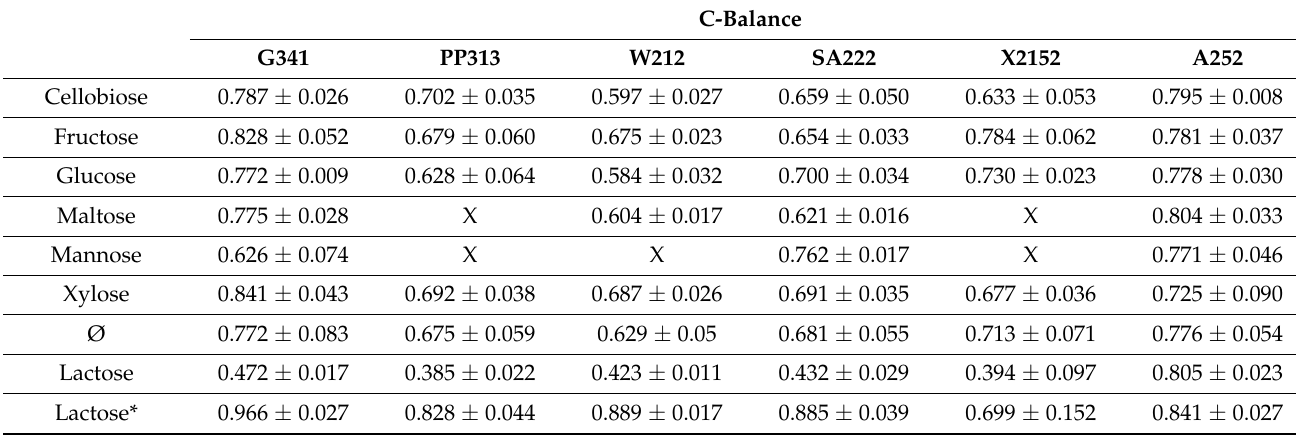
Table 2. Calculated carbon balance without ethanol of the isolates during growth on the C-sources cellobiose, fructose, glucose, maltose, mannose, and xylose. Ø is the average of these sugars. “Lactose” stands for the C-balance during growth on lactose with regard to the hydrolyzed amount of lactose, but not taking into account the actual consumption of released monosaccharides. “Lactose*” is the C-balance including residual